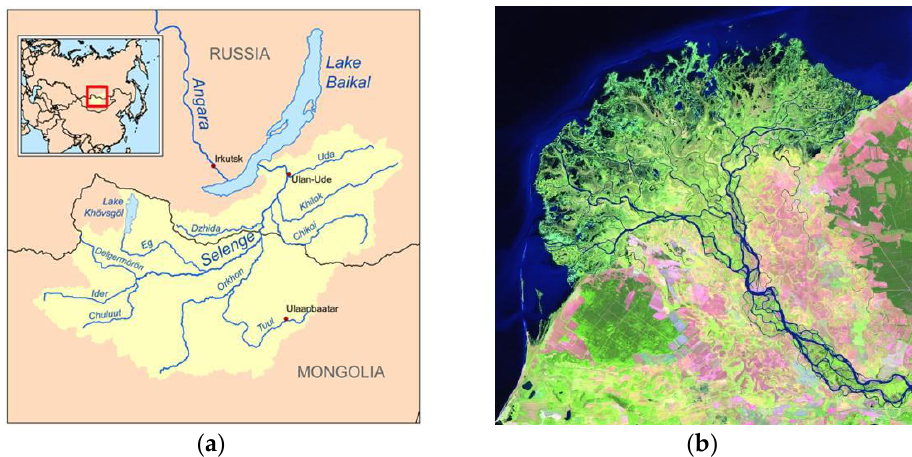
Figure 1. Location map of the study region: ( a ) The Selenga River and its basin (highlighted in yellow). The Selenga flows northeastwards through Mongolia and Russia, and forms a large delta on the southeast coast of Lake Baikal, the world ’ s largest and deepest freshwater lake. ( b ) Satellite image of the Selenga River delta from space (Landsat GeoCover image from the USGS).